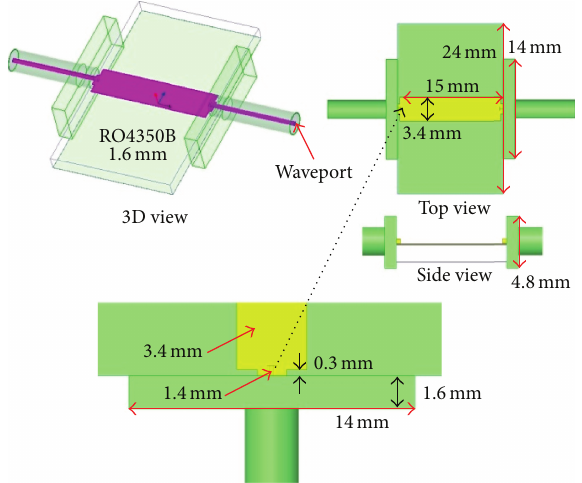
Figure 5: Different view of a detailed EM model, including the MSL, SMA connector, and pieces of coaxial cable. Inner/outer dimensions of the connector and cable are given in the text.